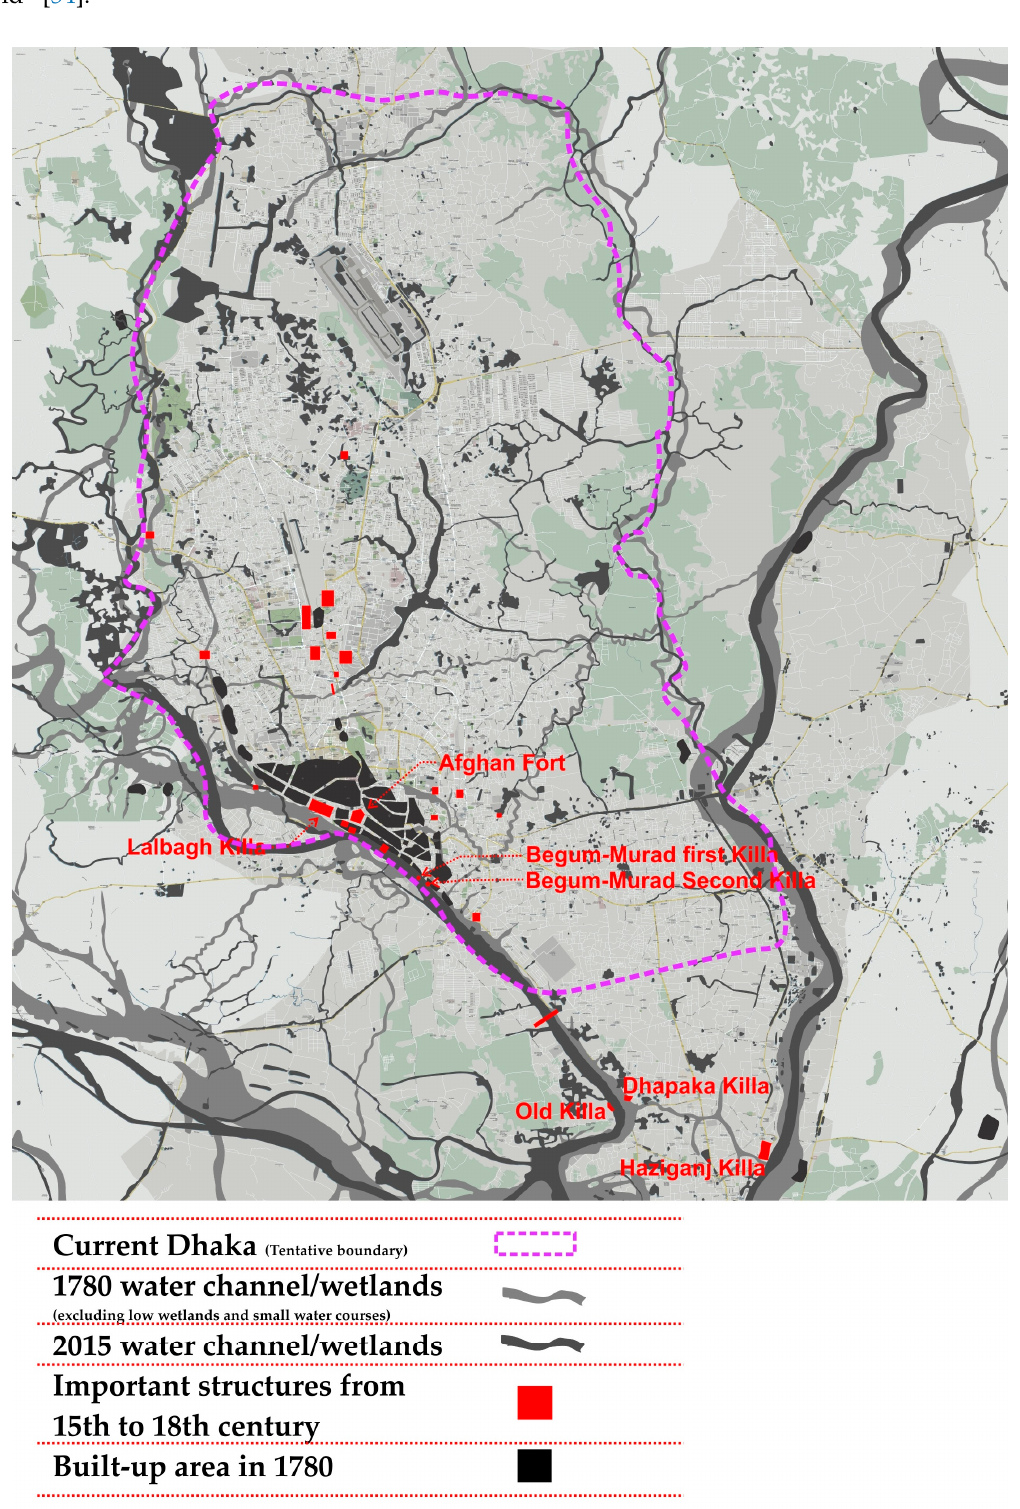
Figure 4. Land use changes in Dhaka during 1780–2015 (not to scale) [Note: Map showing the water channels and urban areas between 1780 and 2015. The historic maps were collected from the National Archive of Bangladesh and the 2015 map is traced from Google images].